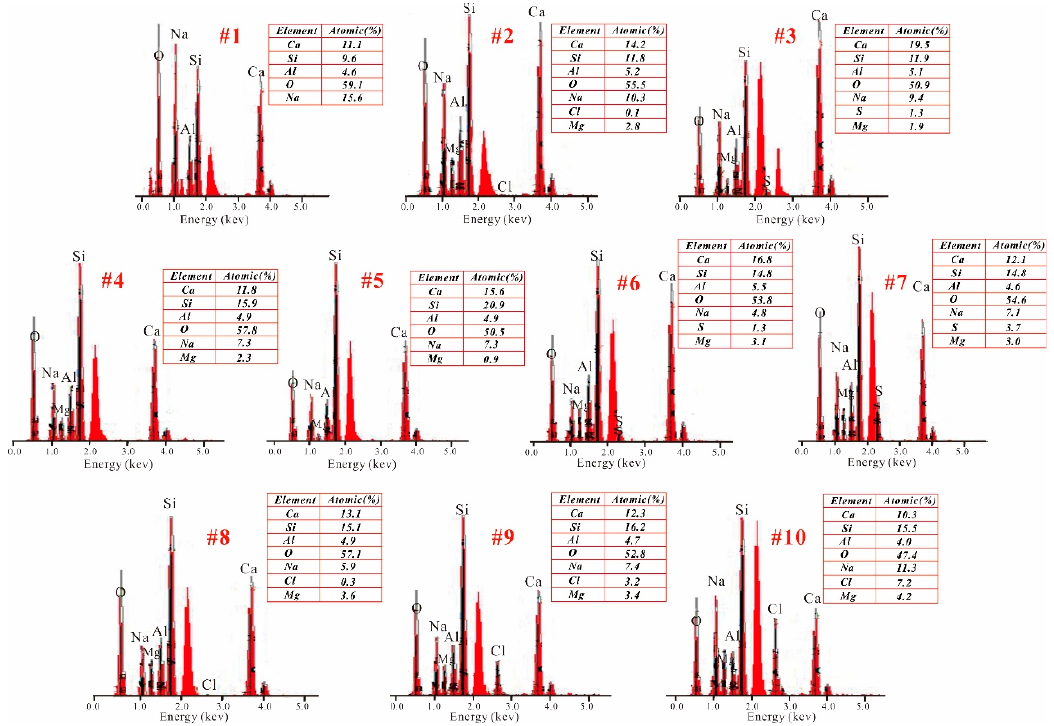
Figure 11. EDX spectra of geopolymers. (The number indicated the red spots in Figures 8–10). Materials 2022 , 15 , x FOR PEER REVIEW